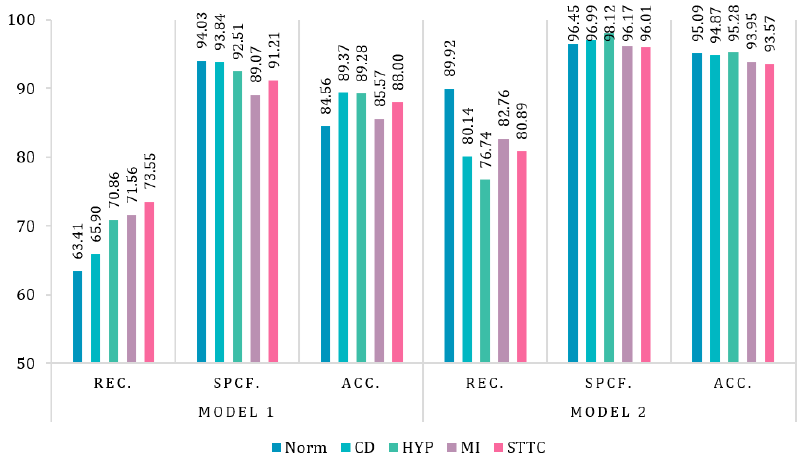
Figure 11. Recall, specificity, and accuracy of two models of each class.